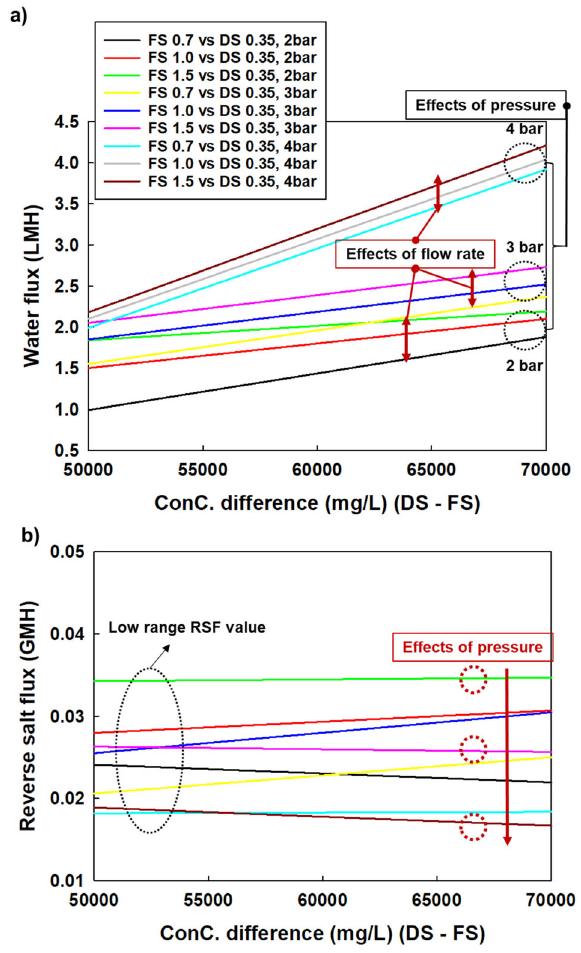
Fig. 2 Water fl ux and RSF variation at various operation conditions with ionic strength in FS. Panels a , b show the water fl ux and RSF values of PAO mode HFFO element at the various concentration and pressure conditions. Synthetic seawater (NaCl) as FS, synthetic seawater or brine (NaCl) as DS, FS concentration of 10,000 – 35,000 mg/L, DS concentrations from 35,000 to 80,000 mg/L, and pressures of 2, 3, and 4 bar. Flow rates: FS: 0.7, 1.0, and 1.5 L/min, and DS: 0.35